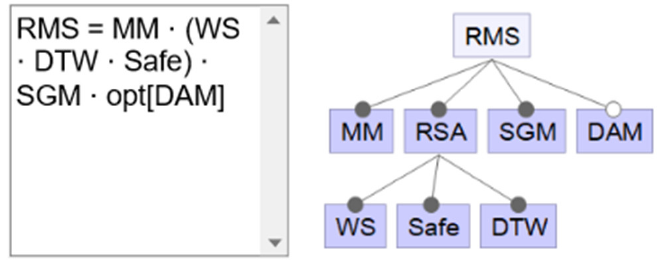
Figure 8. Feature model of the first evolution.